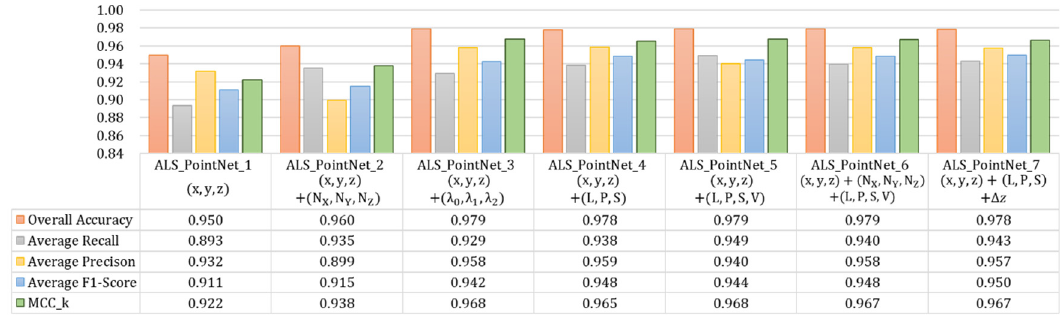
Figure 8. Comparison of classification results using PointNet with different handcrafted features on ALS point clouds.